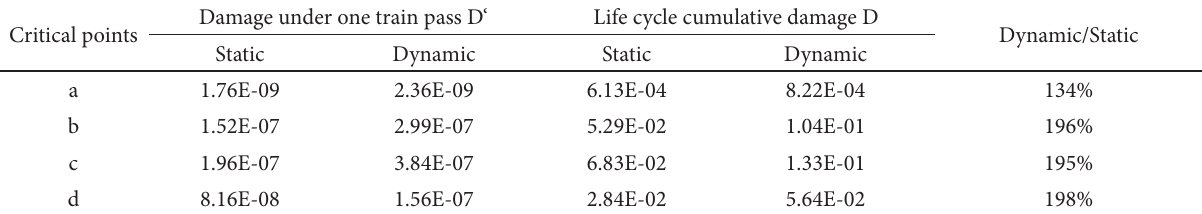
Table 3. Cumulative damage at critical points